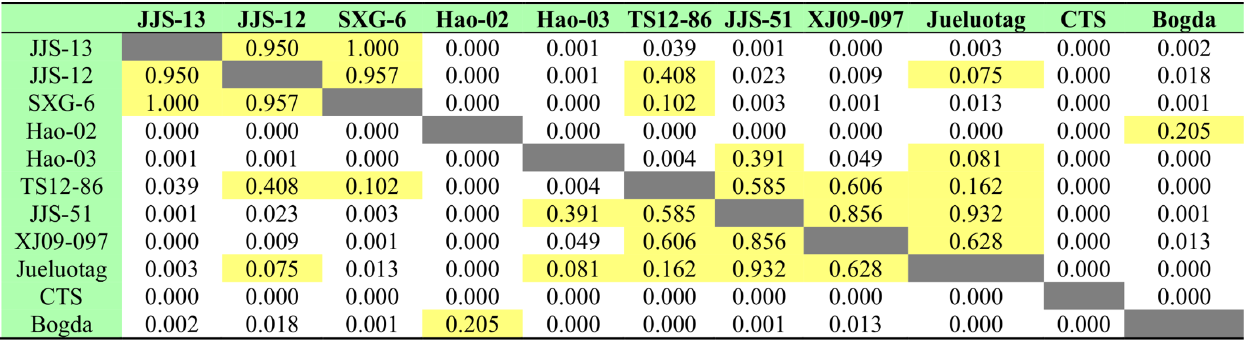
Figure 6. KS P-values tests for Early Jurassic samples (same derived data as those in Figure 5; 95% confidence that the two groups were not statistically different; p -values had to exceed 0.05; comparisons between units with p -values greater than 0.05 are highlighted in yellow).